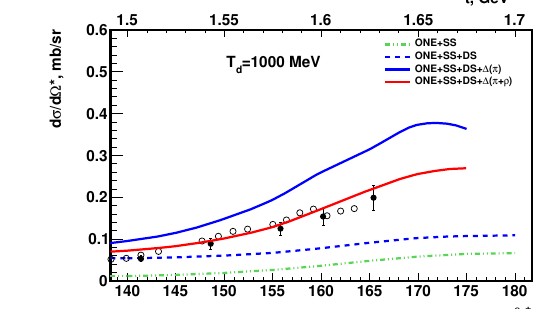
Figure 3: The angular dependence of the differential = 880 MeV. cross section at the deuteron energy at T d The data are from ◦ - [ 22 ] at T = 1169 MeV. T d